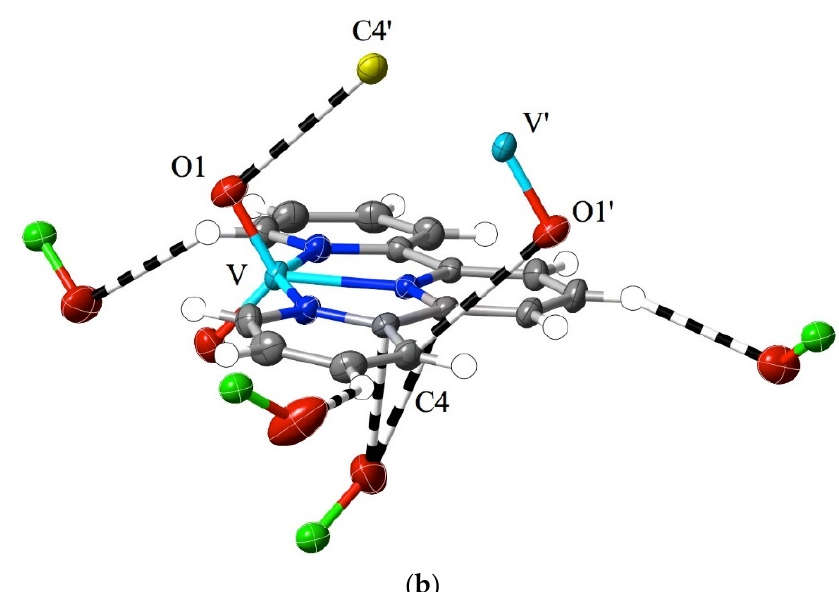
Figure 2. Interactions beyond dispersion, shown as dashed lines, of the cations present in ( a ) [VO 2 ( bptpy )]ClO 4 , 1 and ( b ) [VO 2 ( tpy) ]ClO 4 [44]. O atoms are identified by showing the atoms to which they are attached. Colour coding: C = grey, N = dark blue, O = red, Cl = green, and V = light blue, except for carbon atoms from adjacent cations, which are shown in yellow. H-atoms are shown as small, colourless spheres of arbitrary 0.2 Å radius.